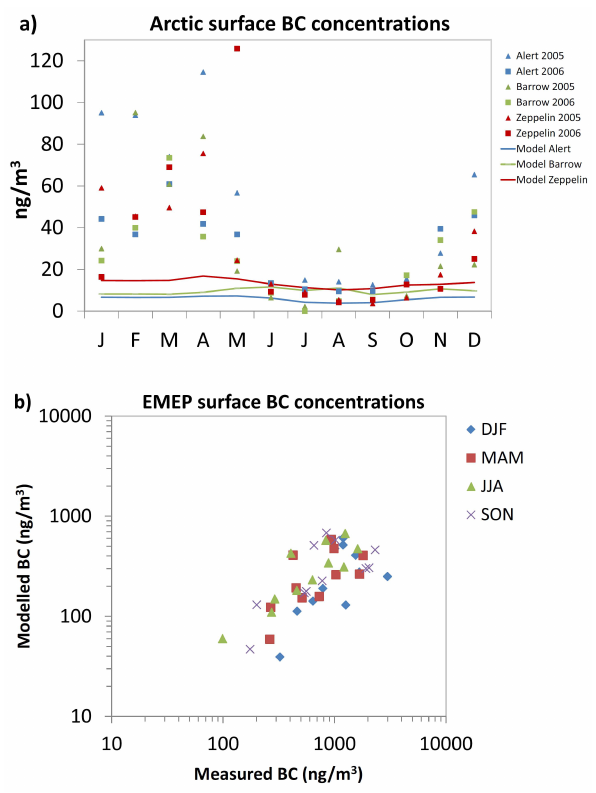
Fig. 2. (a) Monthly mean observed (markers) and modeled (lines) surface BC concentrations from 3 Arctic stations 2005/2006; (b) seasonal mean observed and modeled surface BC concentrations in Europe (from the EMEP 2002/2003 campaign). The modeled sur- face concentrations are from the control run. All units in ngm − 3